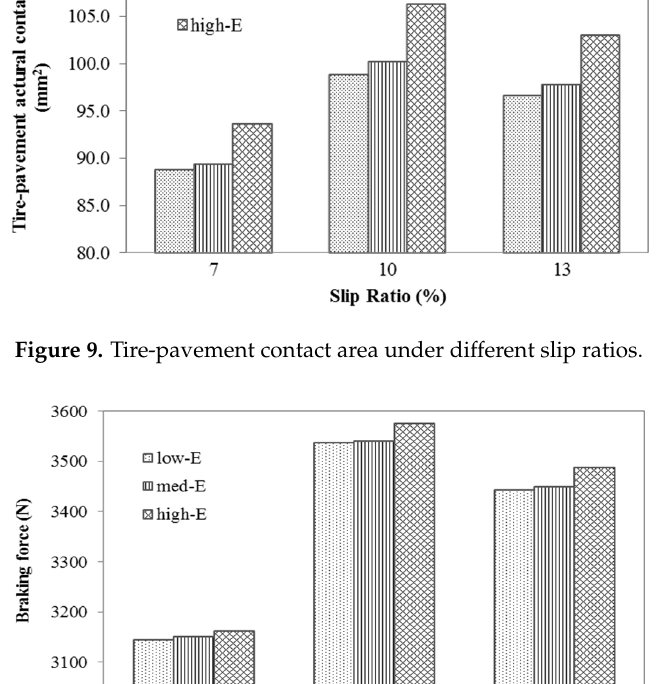
Figure 11. Pavement braking force coefficient under different slip ratios.